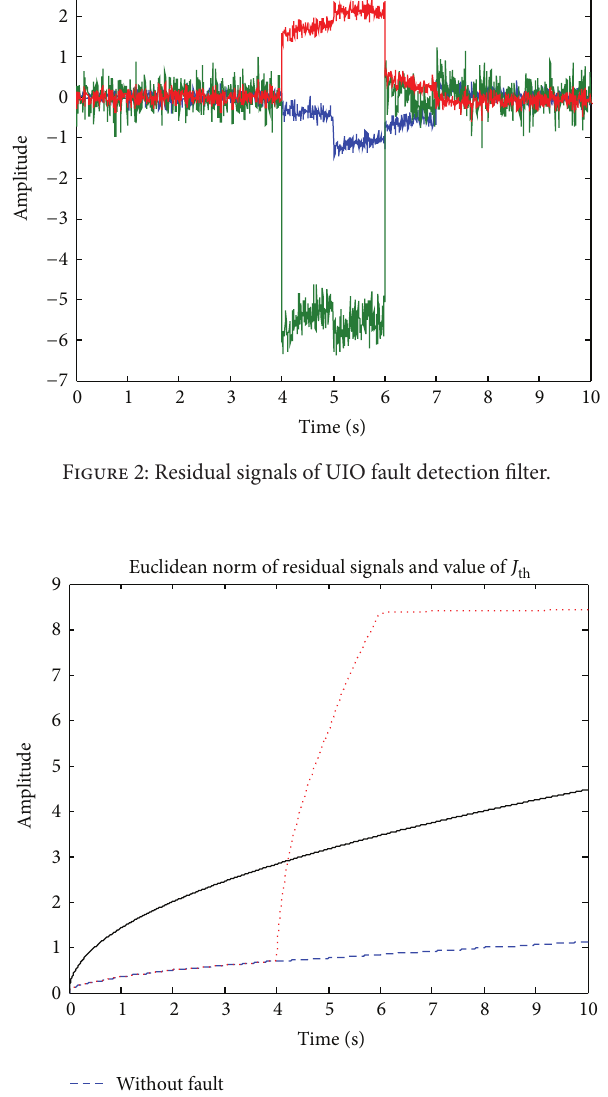
Figure 3: Euclidean norm of residual fault-free and faulty signals . and 𝐽 th